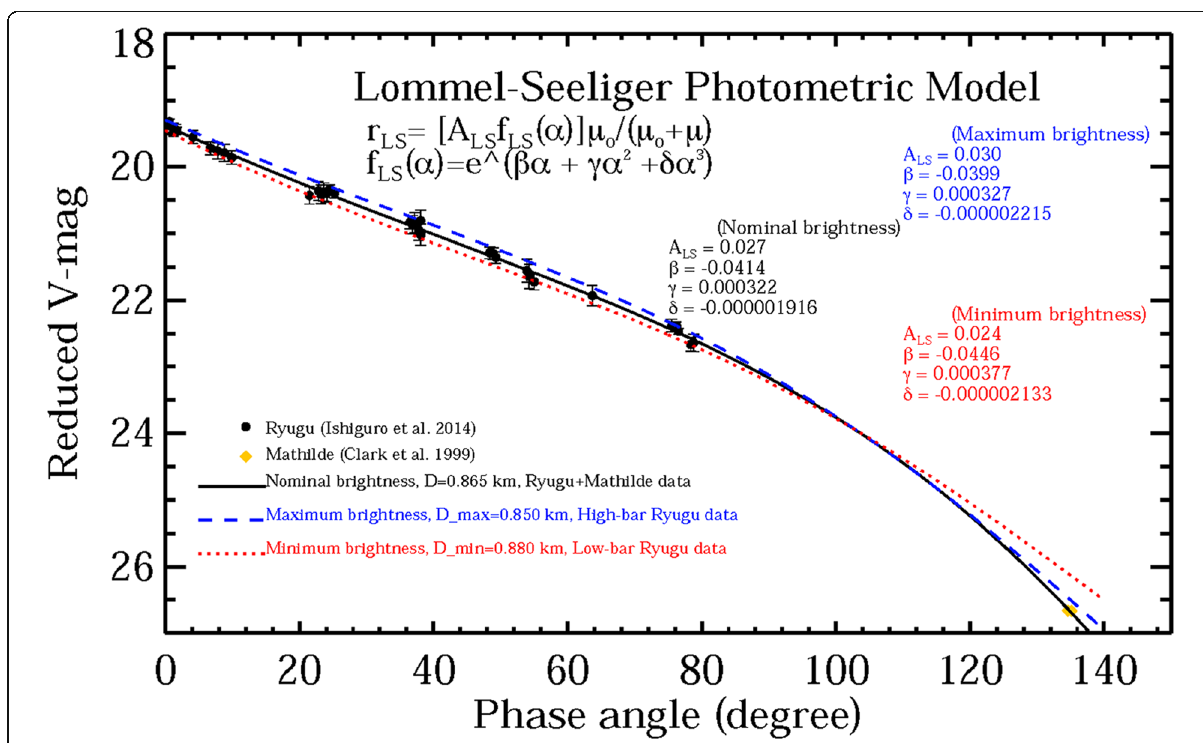
Fig. 3 The reduced V magnitude of Ryugu as a function of phase angle predicted by the Lommel-Seeliger model is shown compared with the ground-based measurements of Ishiguro et al. (2014) and references therein. Shown are the minimum (red dots), maximum (blue dashes), and nominal (black solid line) models. Our minimum and maximum models do not include the Mathilde data; however, our nominal model does. Reflectance r LS is in units of sr − 1 . Figure from Le Corre et al. (2018)